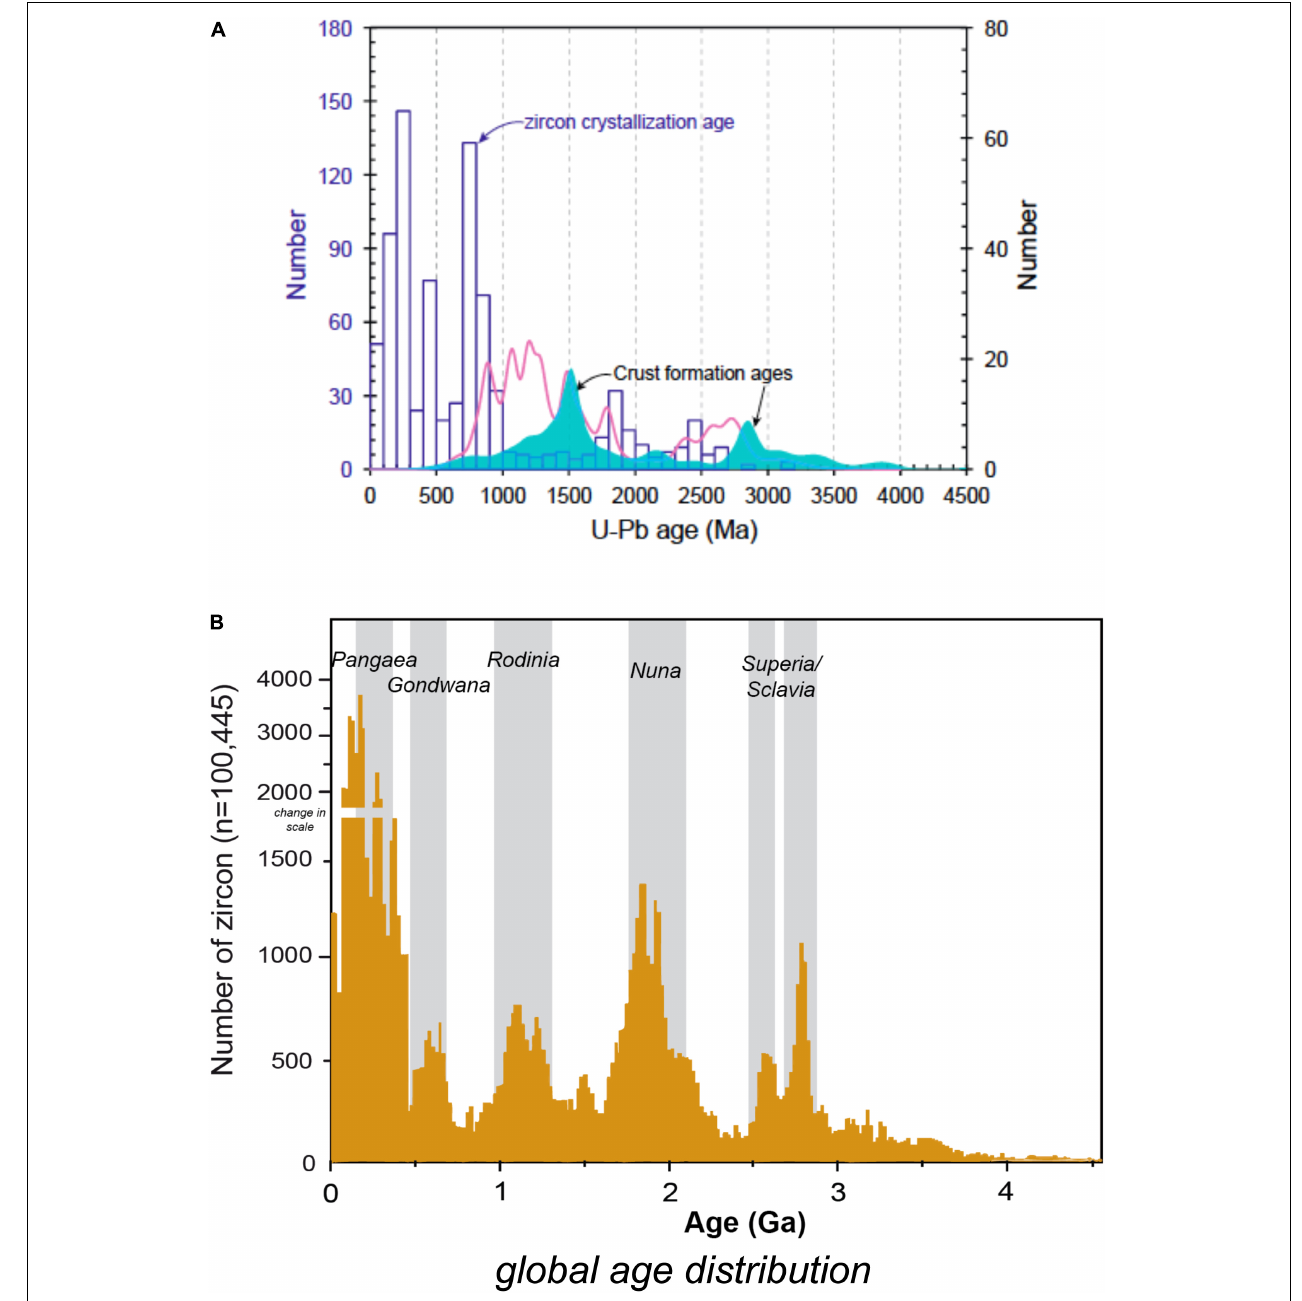
FIGURE 1 | Selected distributions of zircon crystallization ages (A) regionally from the Yangtze River (Liang et al., 2018), and (B) in a global data base (Voice et al., 2011), to highlight the different implications of global and regional age distributions. The gray bars are the estimated ages of supercontinents, taken from Campbell and Allen (2008). The regional age distributions are clearly more closely linked to regional geological events, whereas global signals need to take that into account whether they invoke mantle plumes, or supercontinents, for